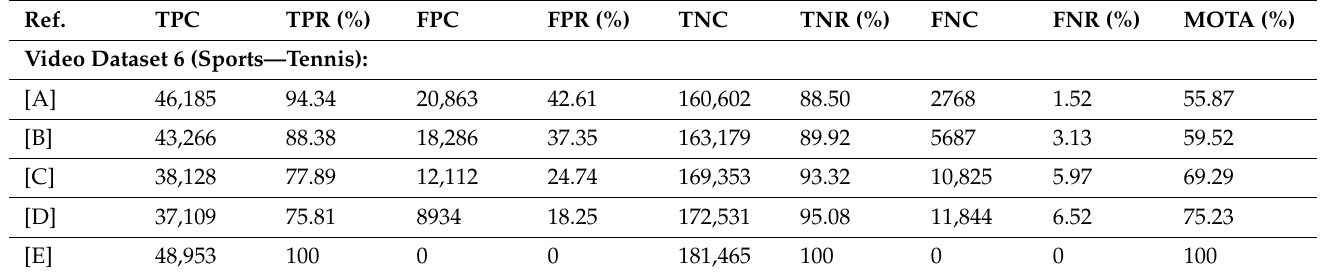
Table 6. Comparison of performance parameters by different approaches tested on video dataset 6: [A] by Pan et al. in [12]; [B] by Mehboob et al. in [13]; [C] by Indu, S. in [14]; [D] our proposed approach; [E] the true data obtained using